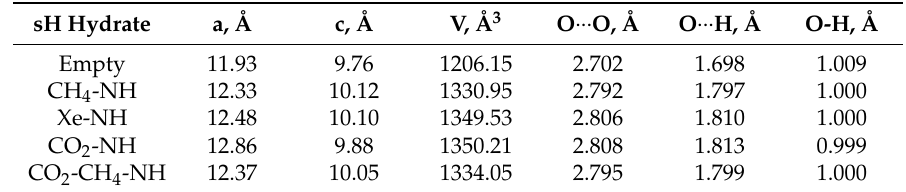
Table 1. Structural characteristics of structure-H (sH) hydrates, a-lattice and c-lattice constants, unit